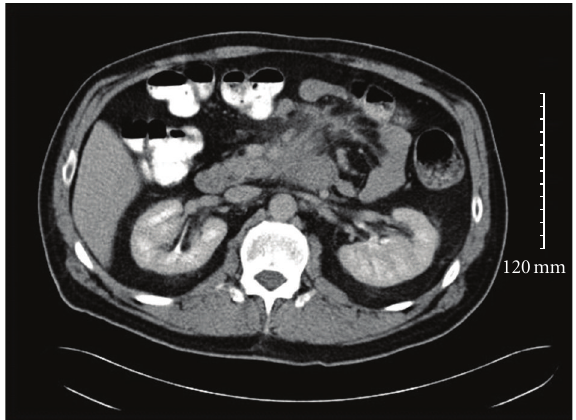
Figure 4: CT abdomen after 1 cycle of chemotherapy showing a decrease in size (2.9cm × 3.5cm × 4.4 cm tissue mass) in the distal duodenal